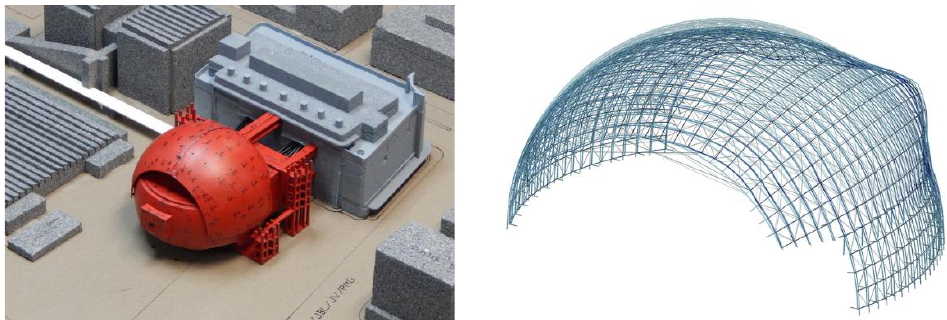
Figs. 6, 7 Wind Testing Model at RWDI laboratories (left) and diagram of deflections (magnified) caused by wind loading (right). Images: RWDI, Knippers